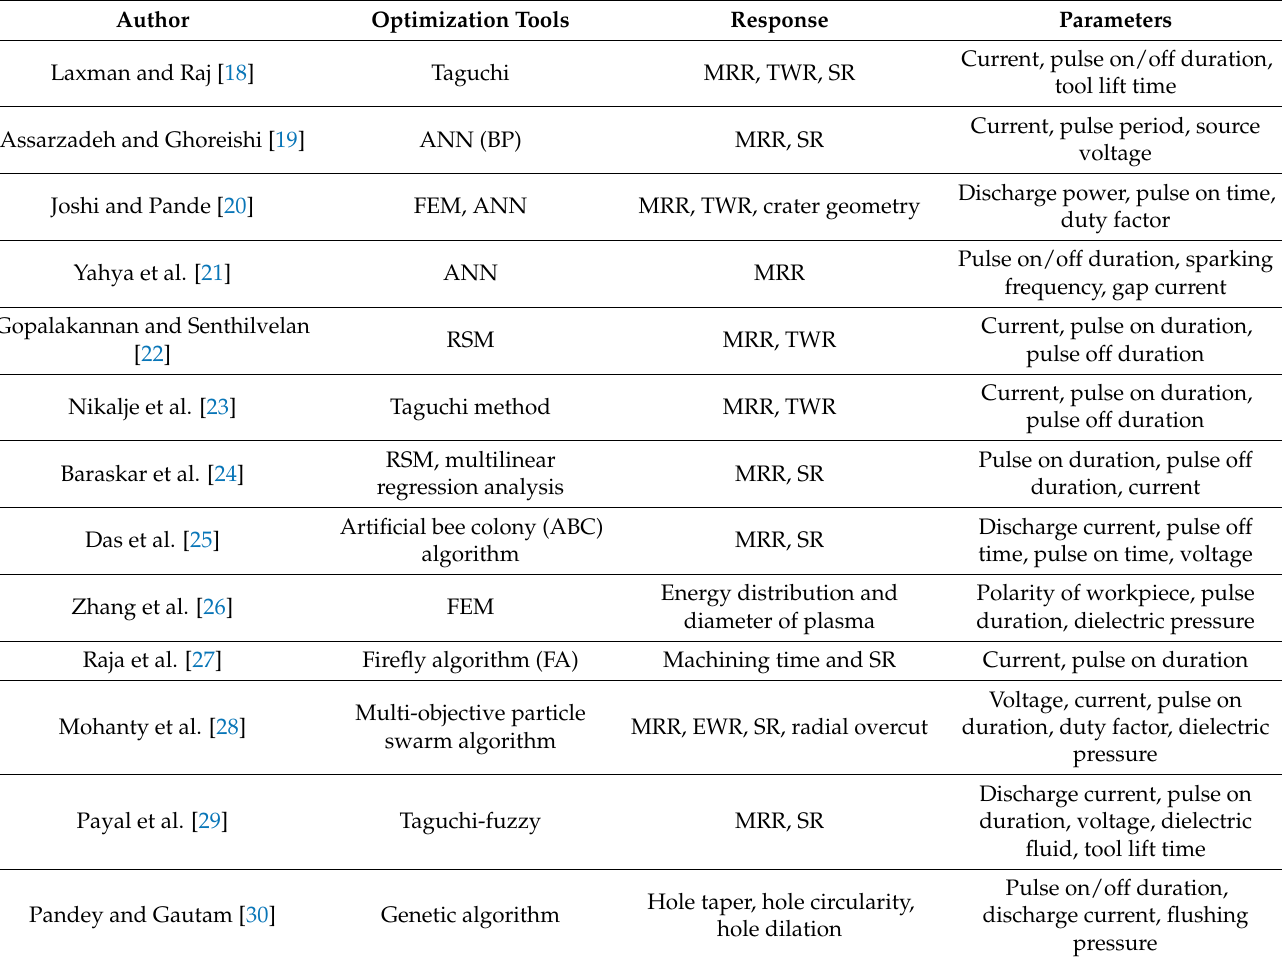
Table 1. Summary of a few key studies used for the analysis of responses